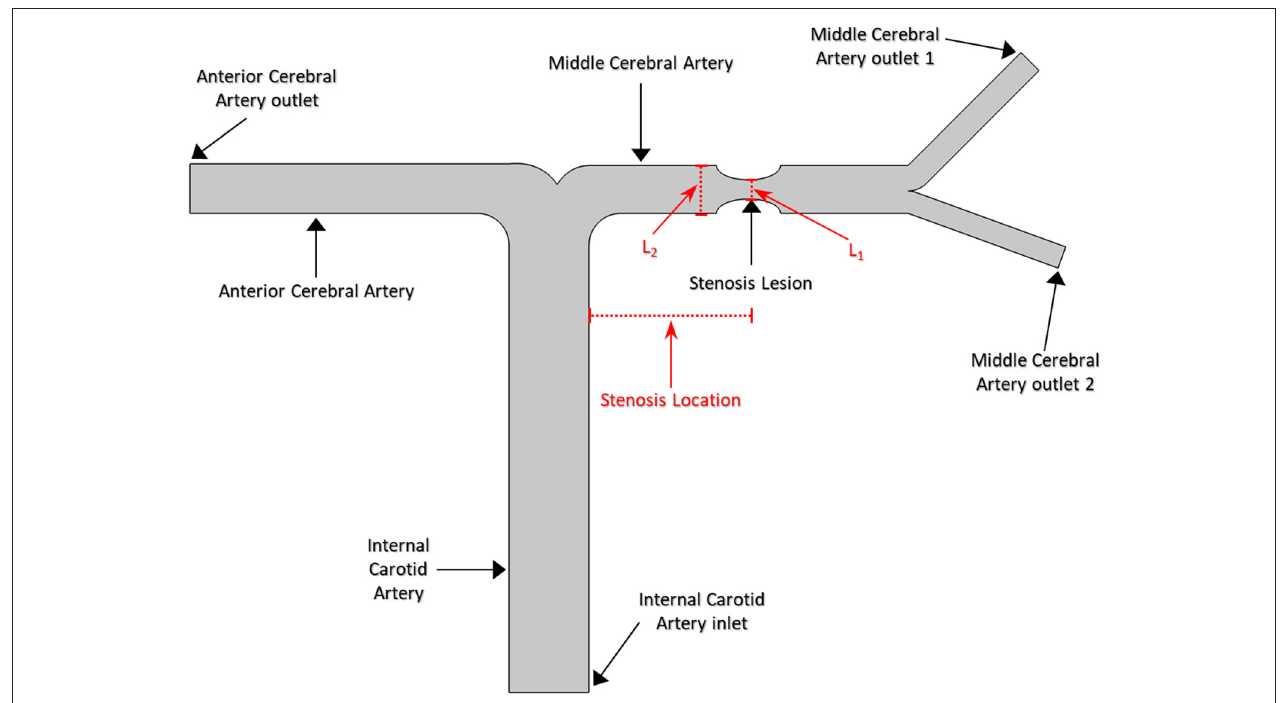
FIGURE 1 | The geometry of the middle cerebral artery and bifurcation in the model.